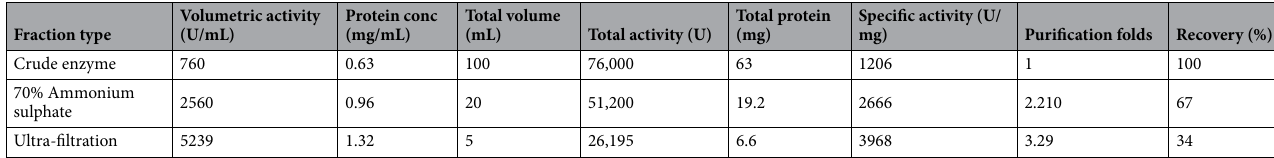
Table 1. Chart for the purification of xylanase